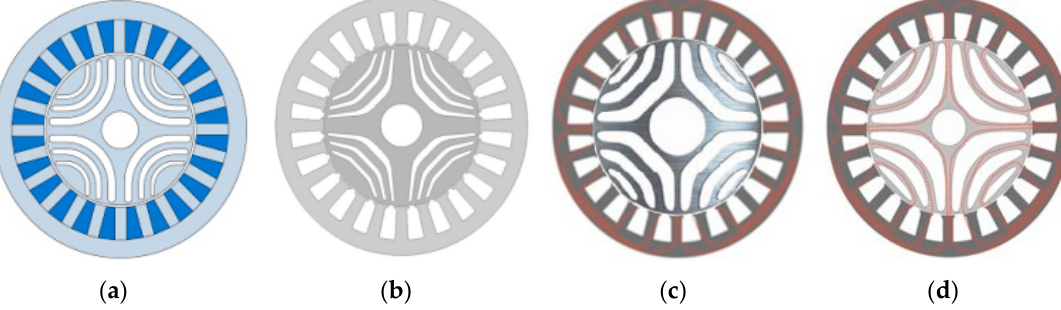
Figure 10. Full cross-section views in four genres of configurations of six-phase synchronous reluctance motor: ( a ) genre 1; ( b ) genre 2; ( c ) genre 3; ( d ) genre